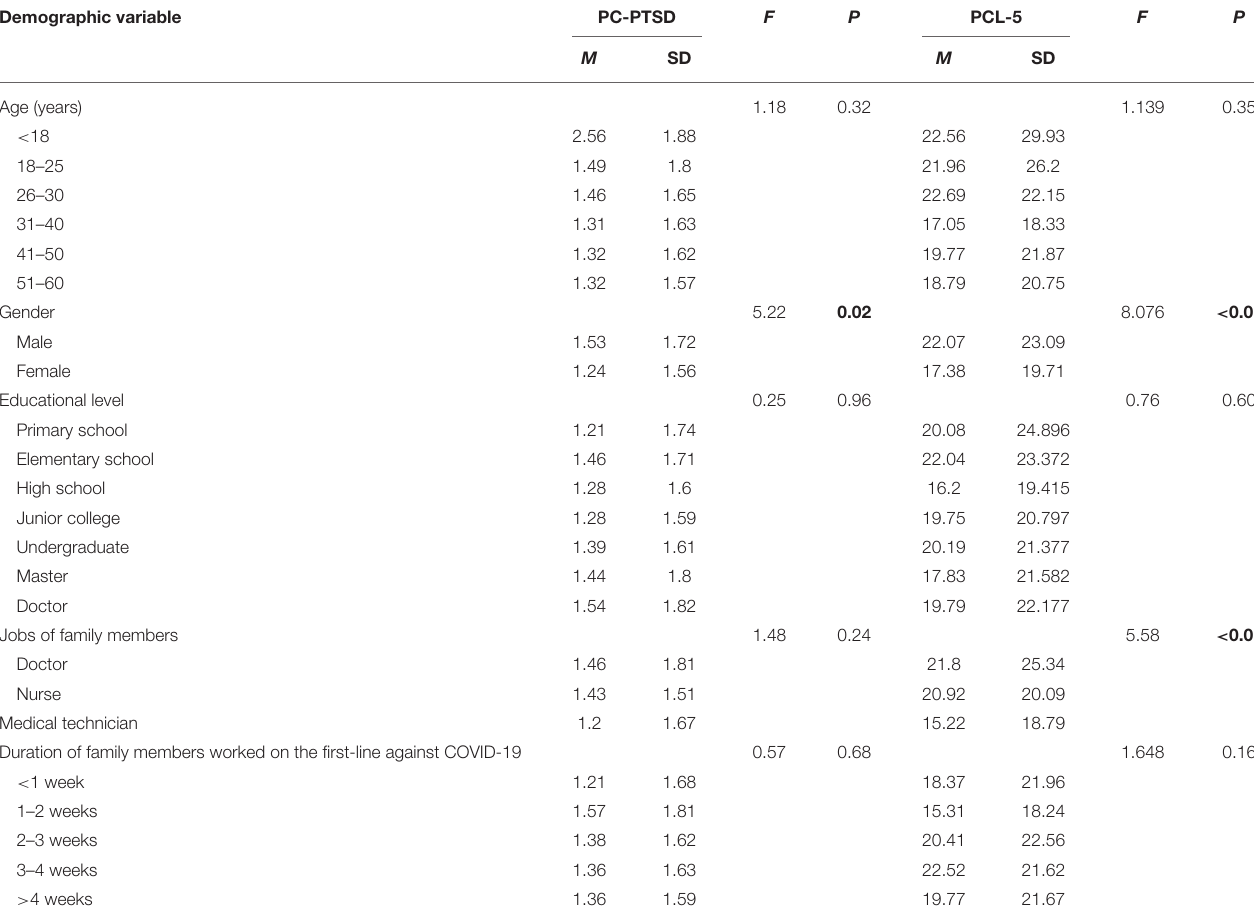
TABLE 3 | Analysis of variance for score of two measurements of PTSD. Demographic